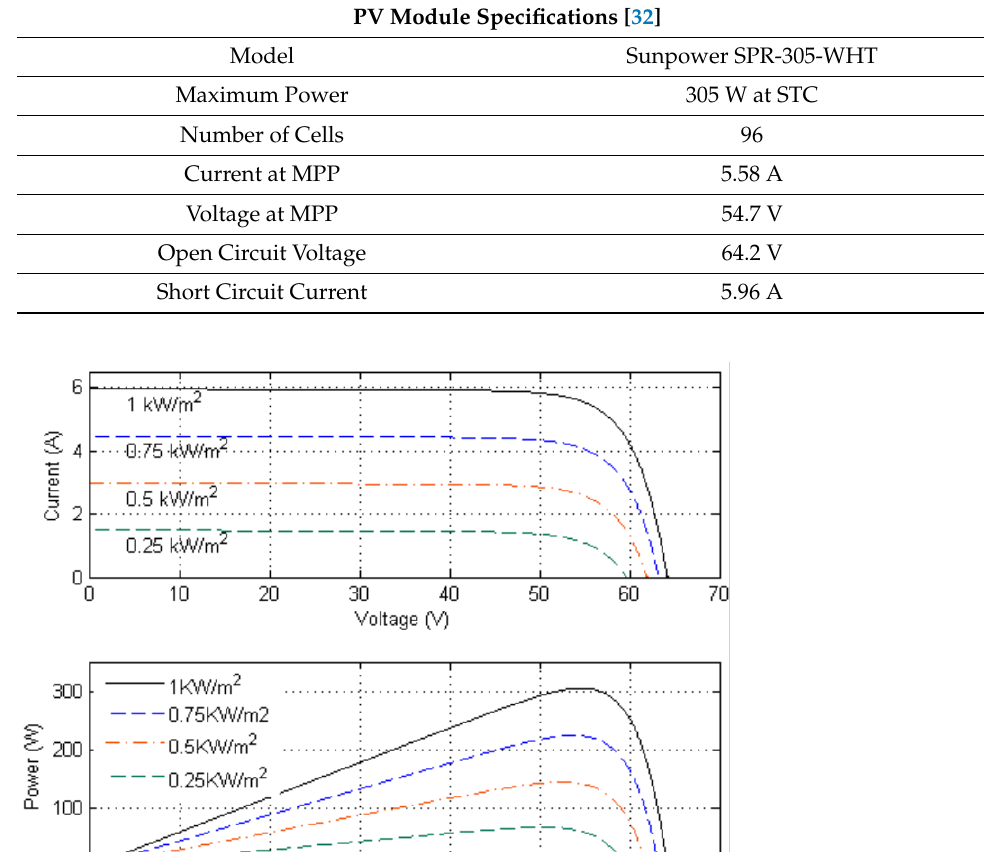
Table 3. Photovoltaic module specifications.